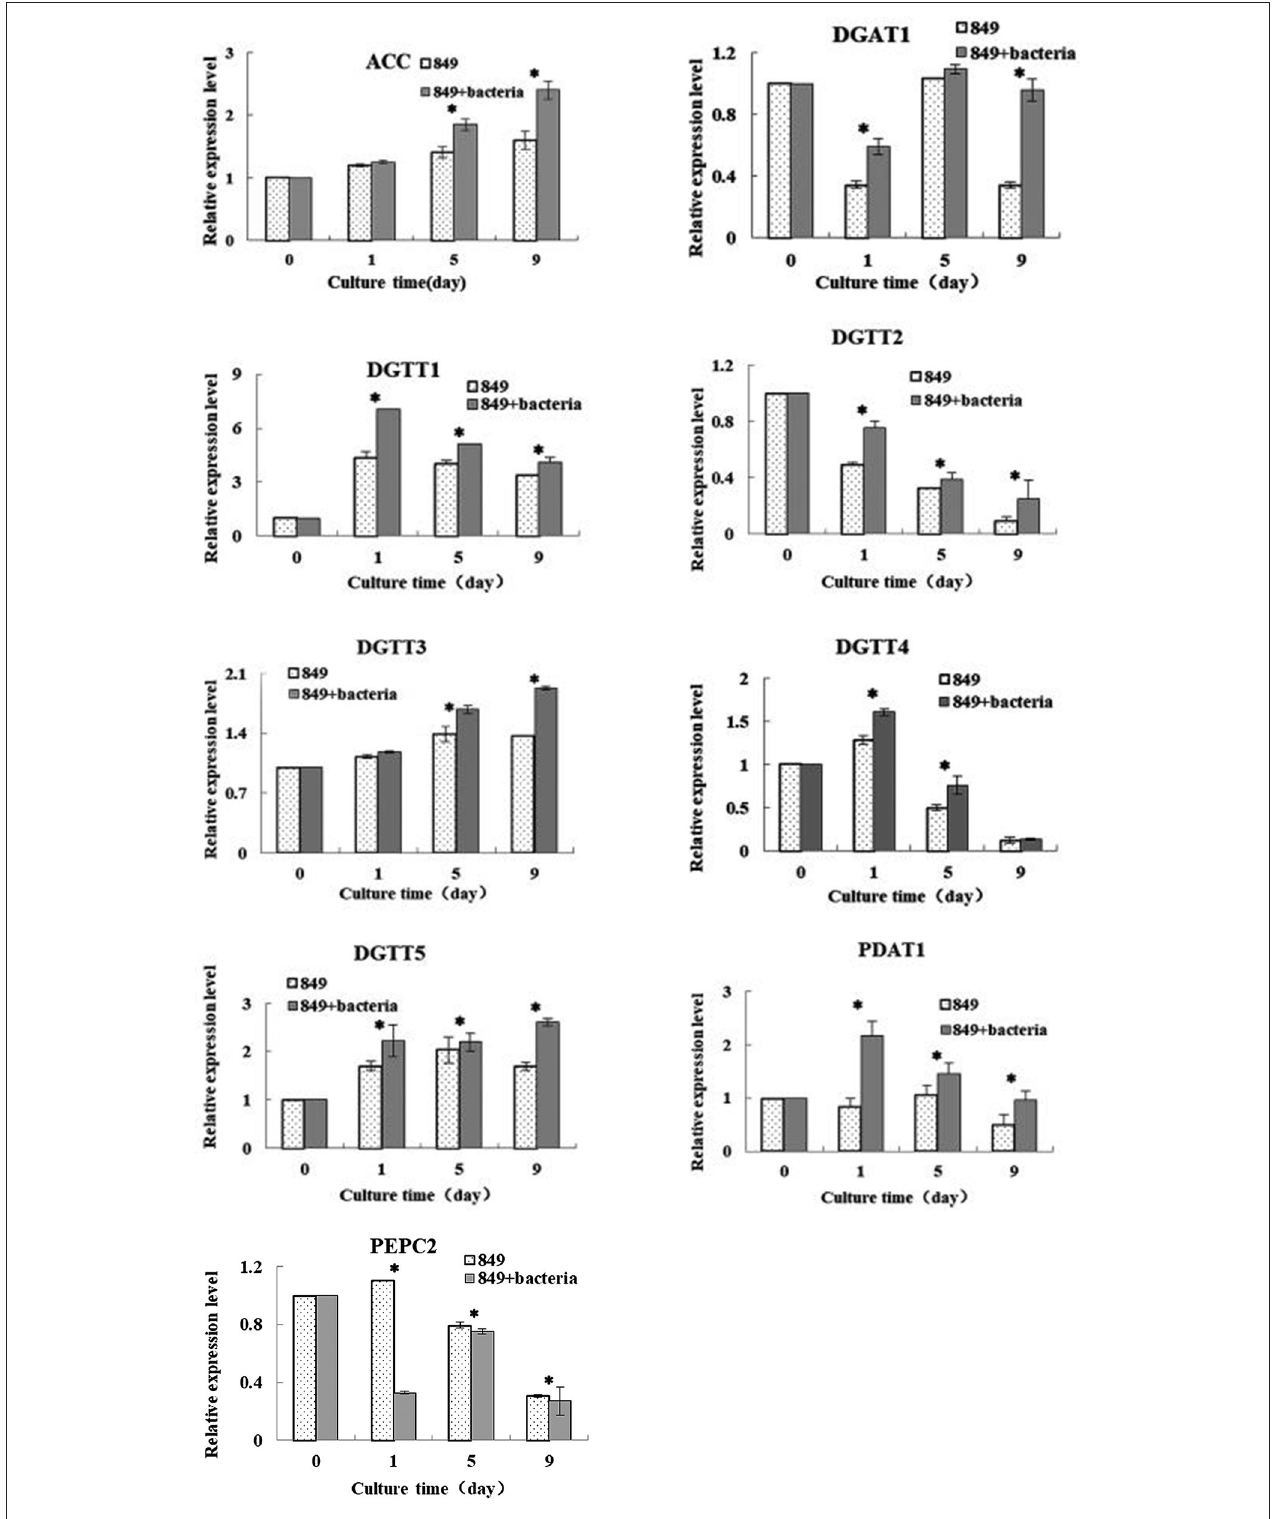
FIGURE 7 | Expression levels of lipid synthesis genes of C. reinhardtii in the co-culture on day 0 (in TAP medium), 1 (the initial stage of lipid production), 5 (logarithmic growth period of lipid production), and 9 (the stable growth period of lipid production) in the TAP-N medium. Examined genes included those encoding diacylglycerol: acetal-CoA carboxylase (ACCase); acyl-CoA aceyltransferases type 1 (DGAT1); and type 2 (DGTT1, DGTT2, DGTT3, and DGTT4); phosphoenolpyruvate carboxylase (PEPC); Phospholipid: diacylglycerol acyitransferase (PDAT). Algae cells were used as controls. The vertical bars indicate standard errors calculated from at least three independent